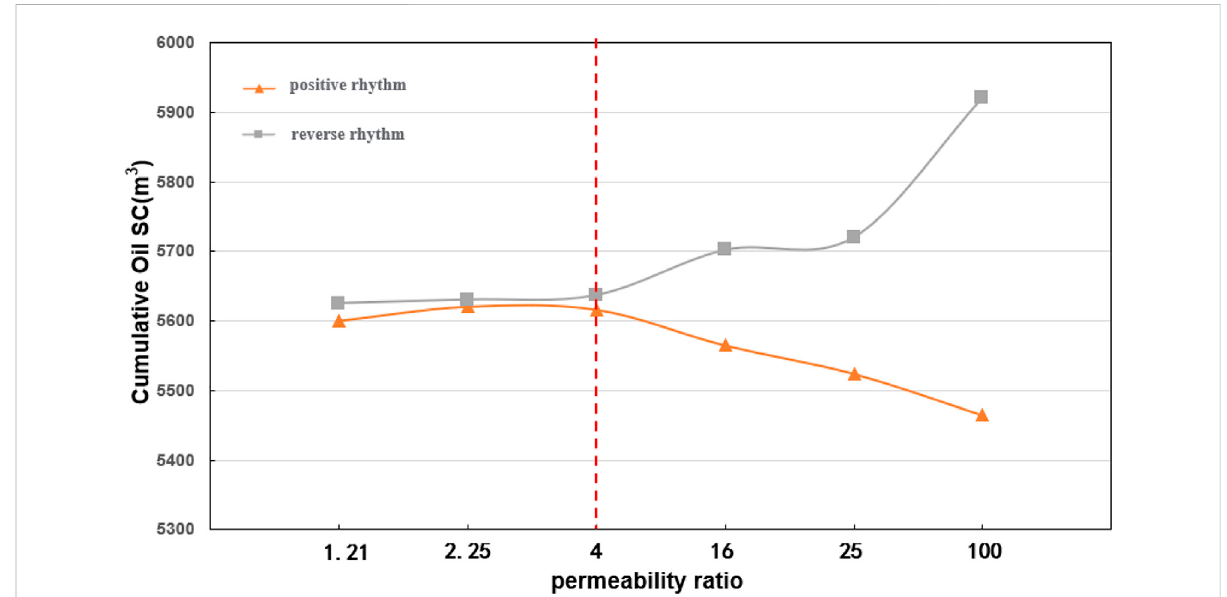
FIGURE 7 Cumulative oil production from W wells under different permeability ratios in positive and reverse rhythm.